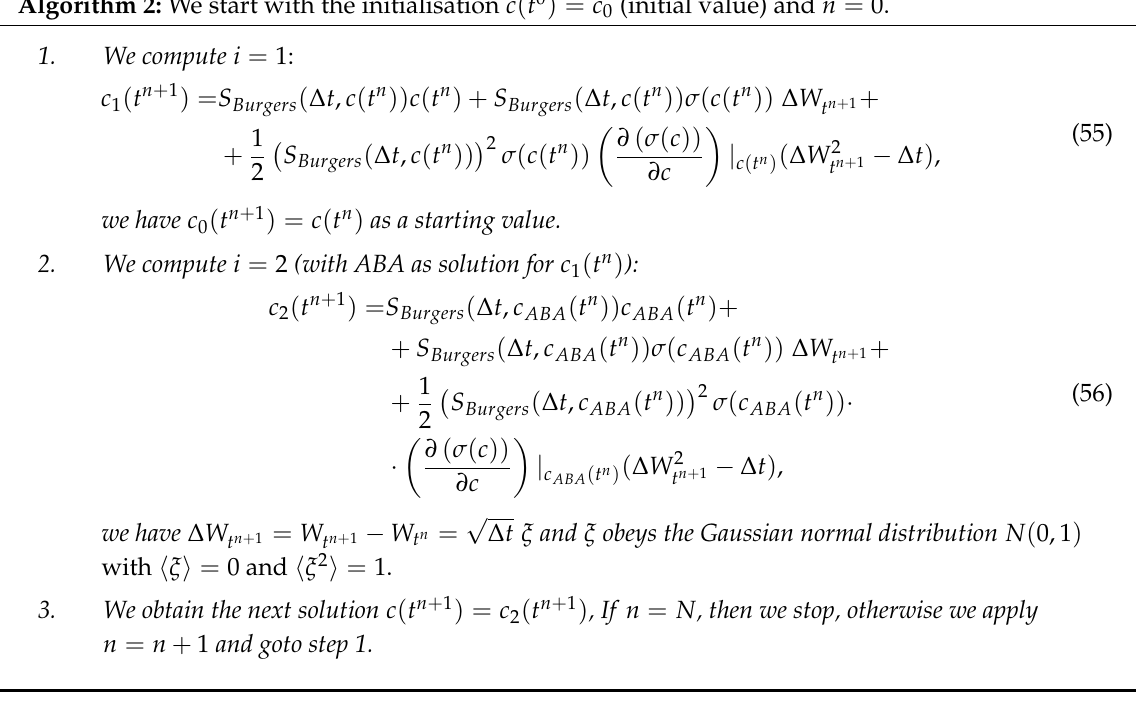
Algorithm 2: We start with the initialisation c ( t 0 ) = c 0 (initial value) and n = 0.